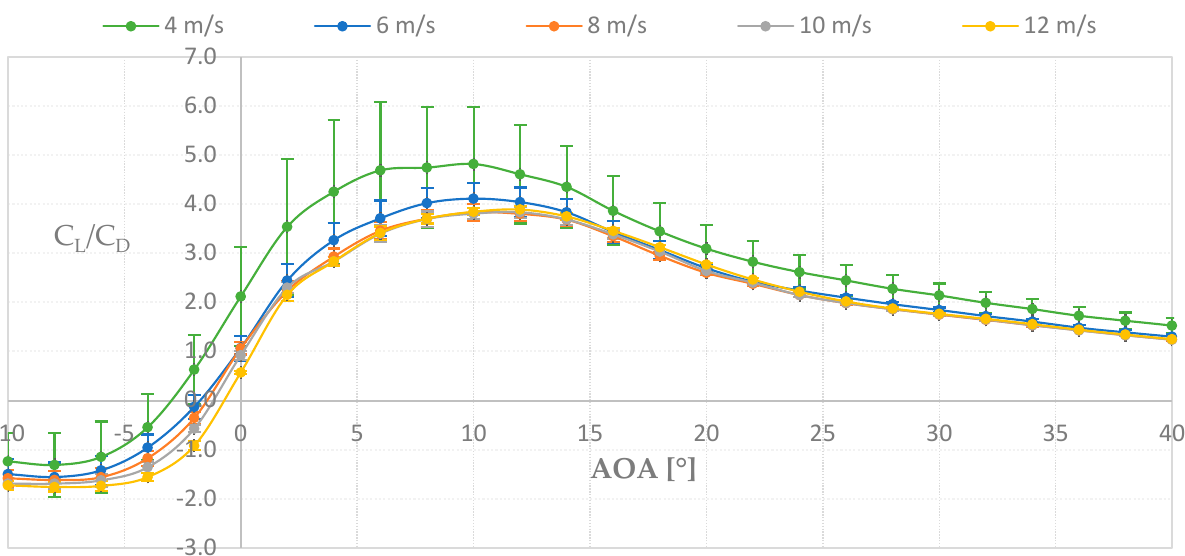
Figure 11. Force measurements of lift − to − drag coefficient against angle of attack for the left wing. For the right wing, up to 40% higher values were found for all velocities compared with the left wing. The higher lift ‐ to ‐ drag coefficients were found at 12 m s − 1 , slightly higher than 4 m s − 1 , see Figure 12. As the same laboratory set ‐ up was used for both wings’ measurements, the right wing was turned upside down in order to perform the tests. We corrected the measurements for gravity effects but nevertheless found higher values for the up-side-down right wing which will be evaluated in the Discussion section. For now, we consider our results to be adequate for further analysis towards a marine application, with emphasis on the left wing results.